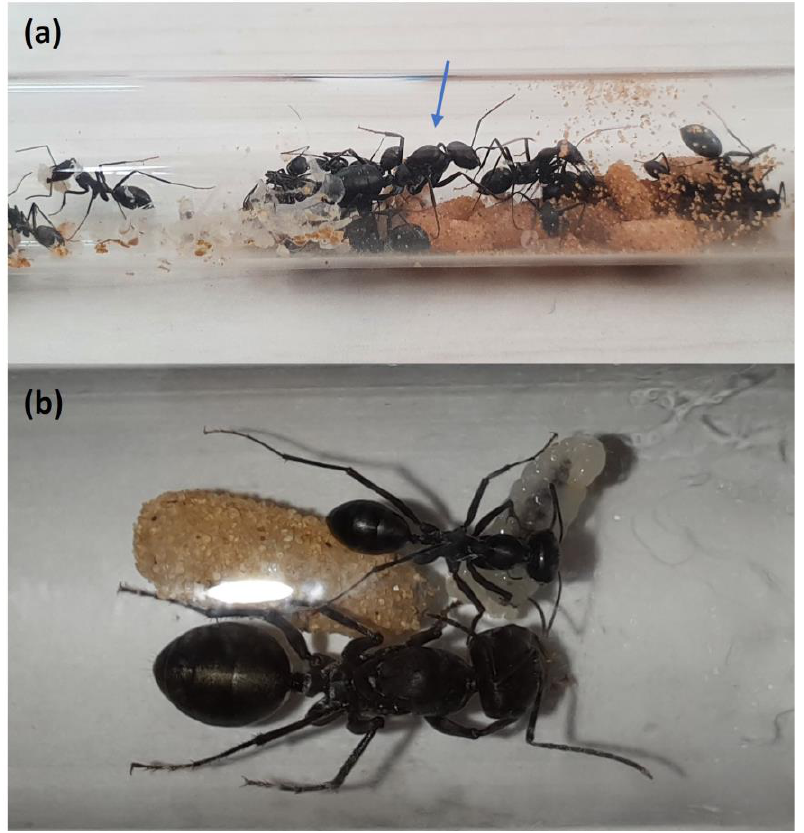
Figure 1. ( a ) A queen (center, marked with an arrow), workers, pupae (right), and a worker holding an egg (left) of the studied species Cataglyphis niger . ( b ) A C. niger queen (down), worker (up), pupa (left), and larva